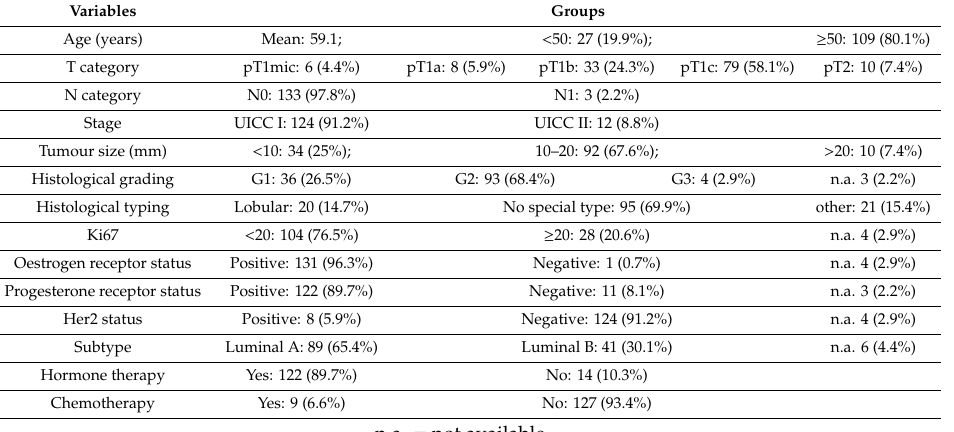
Table 1. Clinical characteristics.